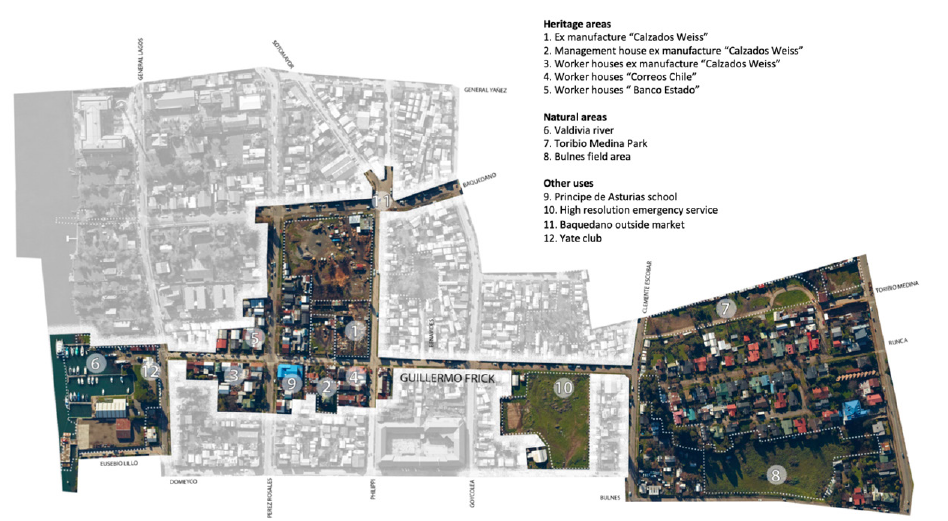
Figure 2. Guillermo Frick Street environment. Urban sector